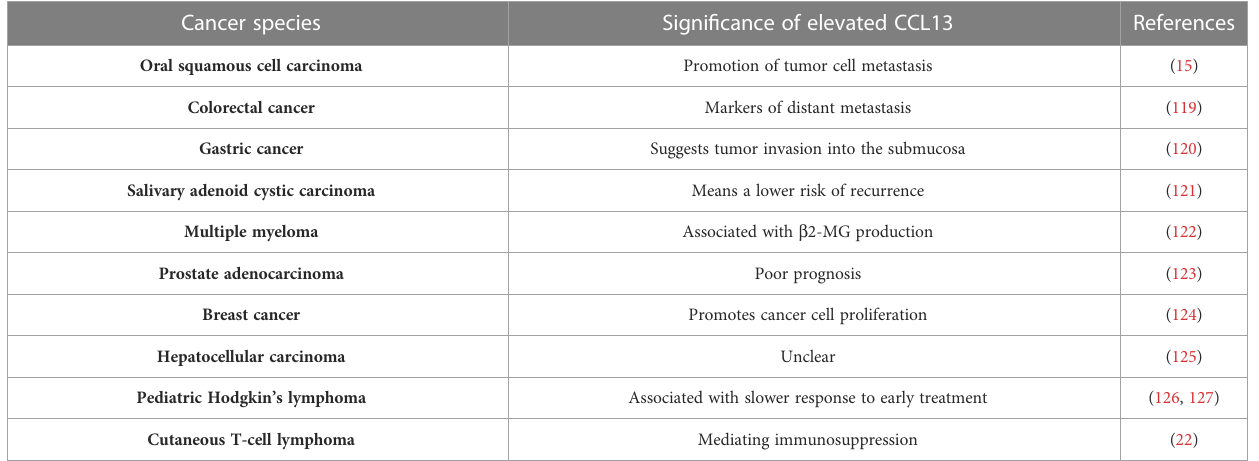
TABLE 3 Effect of CCL13 on phenotype in tumors or its clinical signi fi cance. Cancer species Signi fi cance of elevated